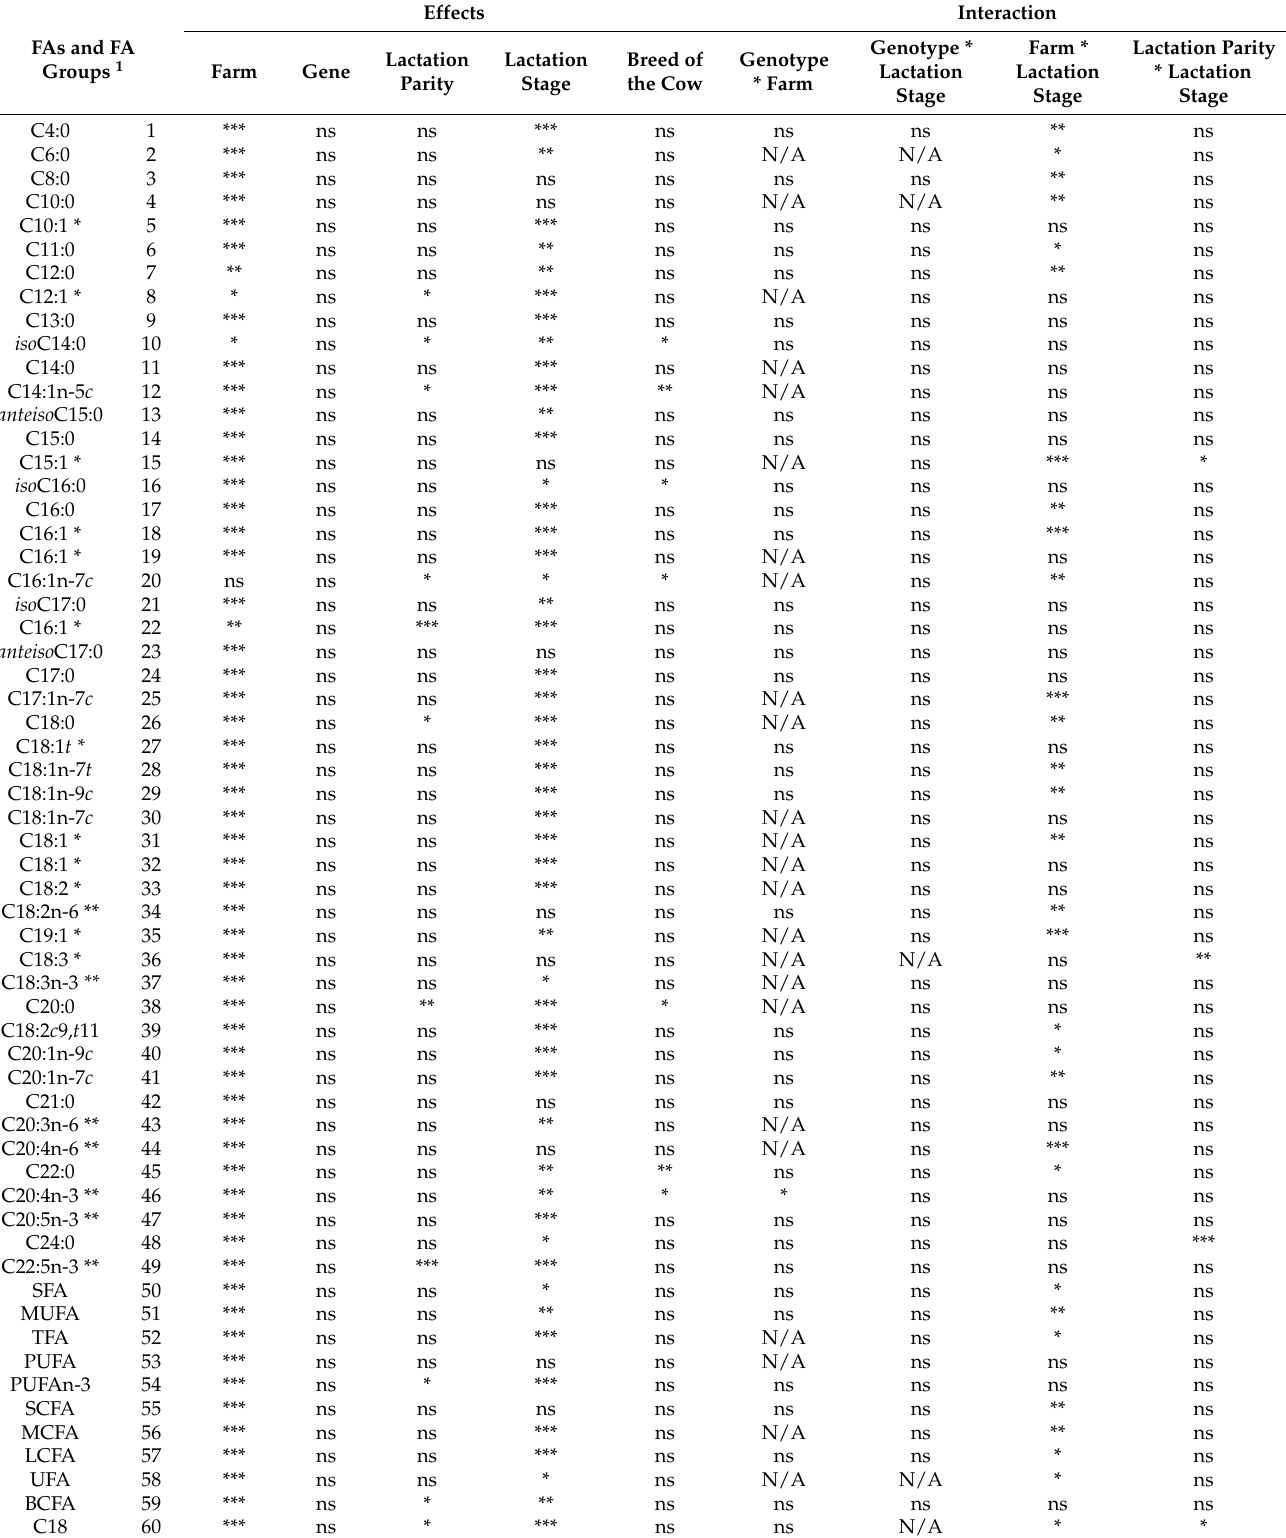
Table 3. Effects on the fatty acid (FA) proportions ( p- values)— AGPAT6 gene.